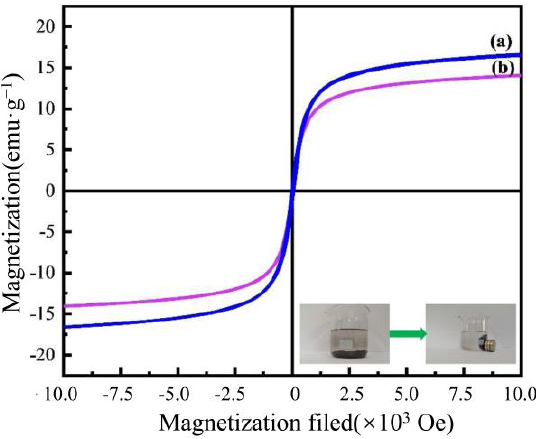
Figure 4. Magnetization curves of the AAM-MSMPM ( a ) and Cd(II)/AAM-MSMPM ( b ), and the inset of (b) is the separation of the AAM-MSMPM from the solution in a magnetic field.